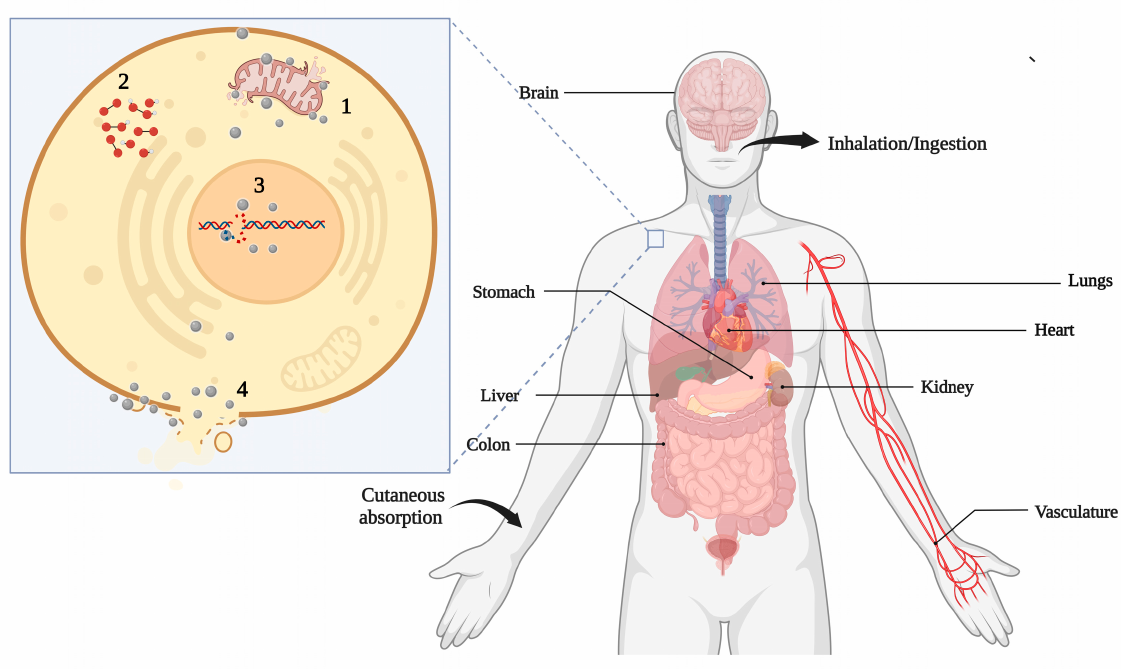
Figure 5. Major possible consequences of the toxicity of nanomaterials to human health. The main routes of exposure are ingestion, inhalation, and absorption through the skin, which can cause damage to different organs such as the lungs, kidneys, heart, stomach, and liver. At the cellular level, nanomaterials are believed to affect cells through mitochondrial damage (1), ROS production (2), DNA and protein damage (3) as well as cell membrane disruption (4).